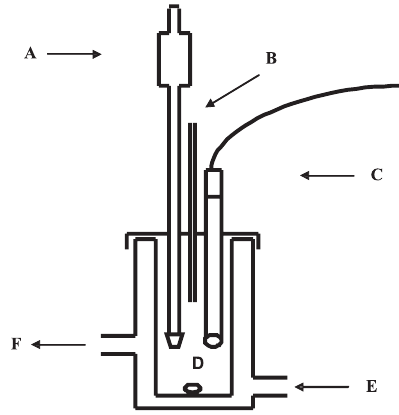
Figura 1. Esquema do equipamento de titulação redox. A: microbureta; B: tubo para entrada de Ar; C: eletrodo de Pt combinado (referência AgCl, Ag); D: agitador magnético; E e F: entrada e saída de água a 25 °C,